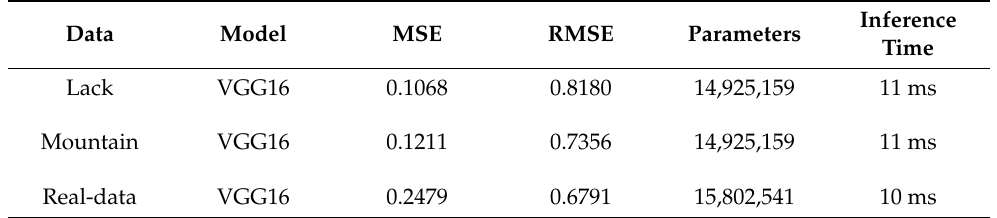
Table 5. Experimental results without the proposed model in terms of MSE, RMSE, parameters, and inference time for model